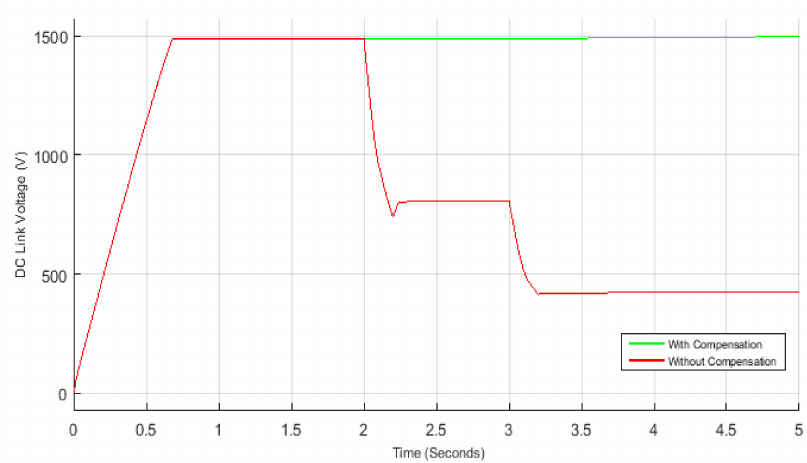
Figure 24. DC link voltage with and without